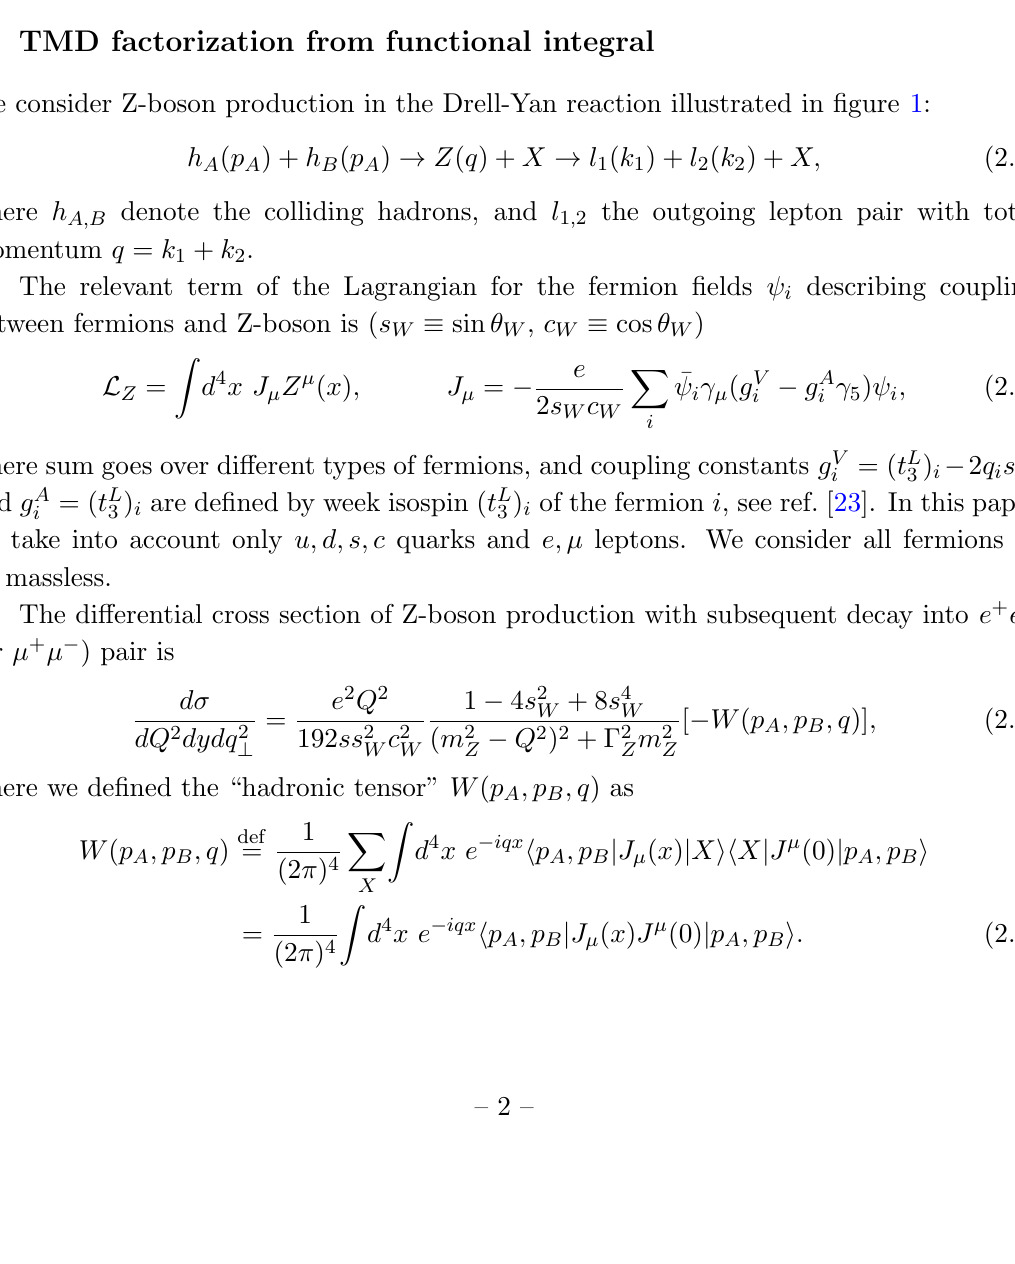
Figure 1 . Z-boson production in hadron-hadron